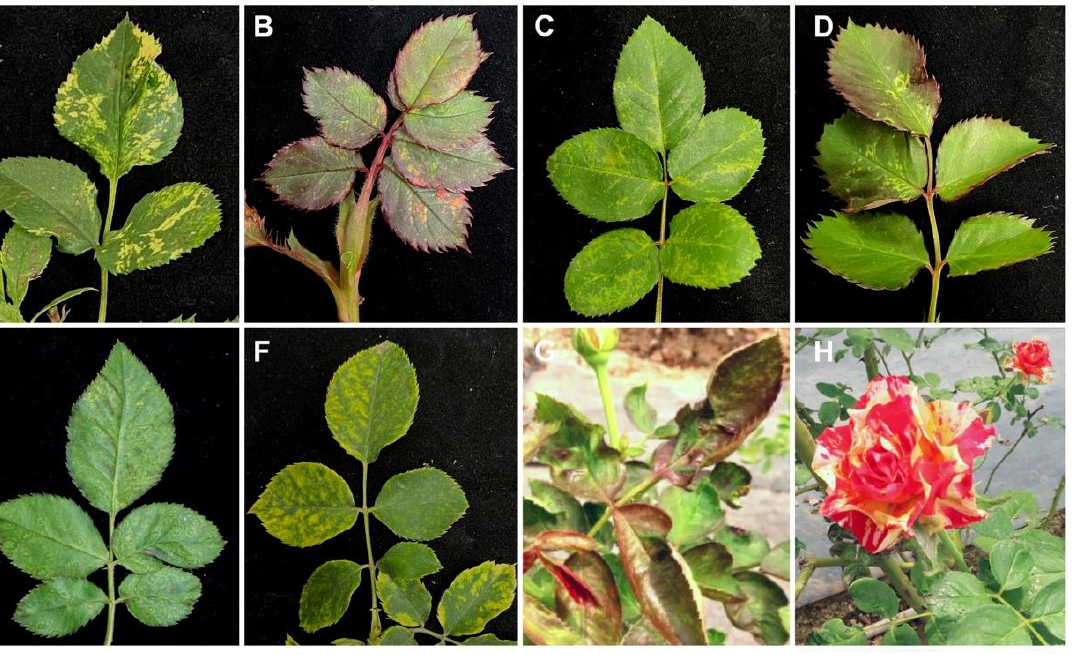
Figure 1. Symptom observations of roses. ( A ) yellow patterns, ( B ) reddish spots, ( C ) mottling with chlorotic patterns, ( D ) yellow spots, ( E ) ringspots, ( F ) mosaic with yellow spots, ( G ) wrinkle-curling on leaves and ( H ) color-breaking on flowers are shown. Viruses detected in the rose samples are listed in Table S4.